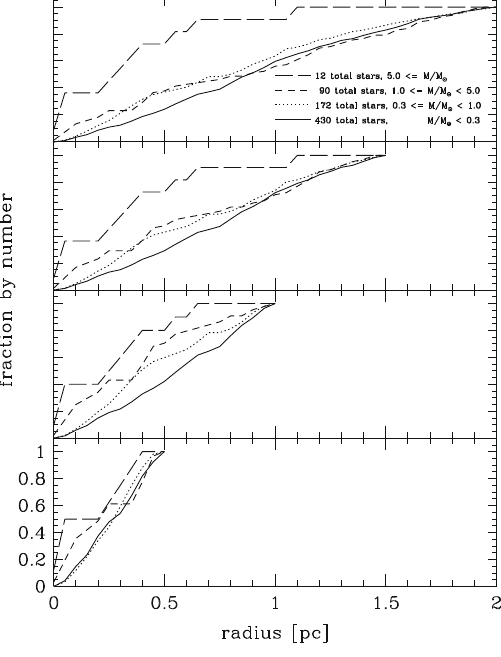
Fig. 23 In this plot, we see mass-segregation of stars more massive than 5 M (cid:2) (long-dashed lines) toward the cluster centre and some evidence for general mass segregation persisting down to 1–2 M (cid:2) in the Orion Nebula cluster. The cumulative radial distributions of source counts over different mass intervals are shown. To clarify the sensitivity of the cumulative plots to the outer radius they have shown here four panels with four different limiting radii. Image reproduced with permission from Hillenbrand and Hartmann (1998), copyright by